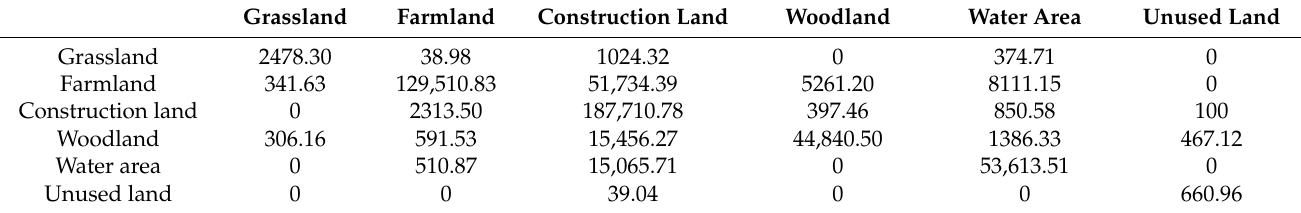
Table 8. Land-use transition matrix in non-ecological redline areas during 2005–2018 (ha). Grassland Farmland Construction Land Woodland Water Area Unused Land Grassland